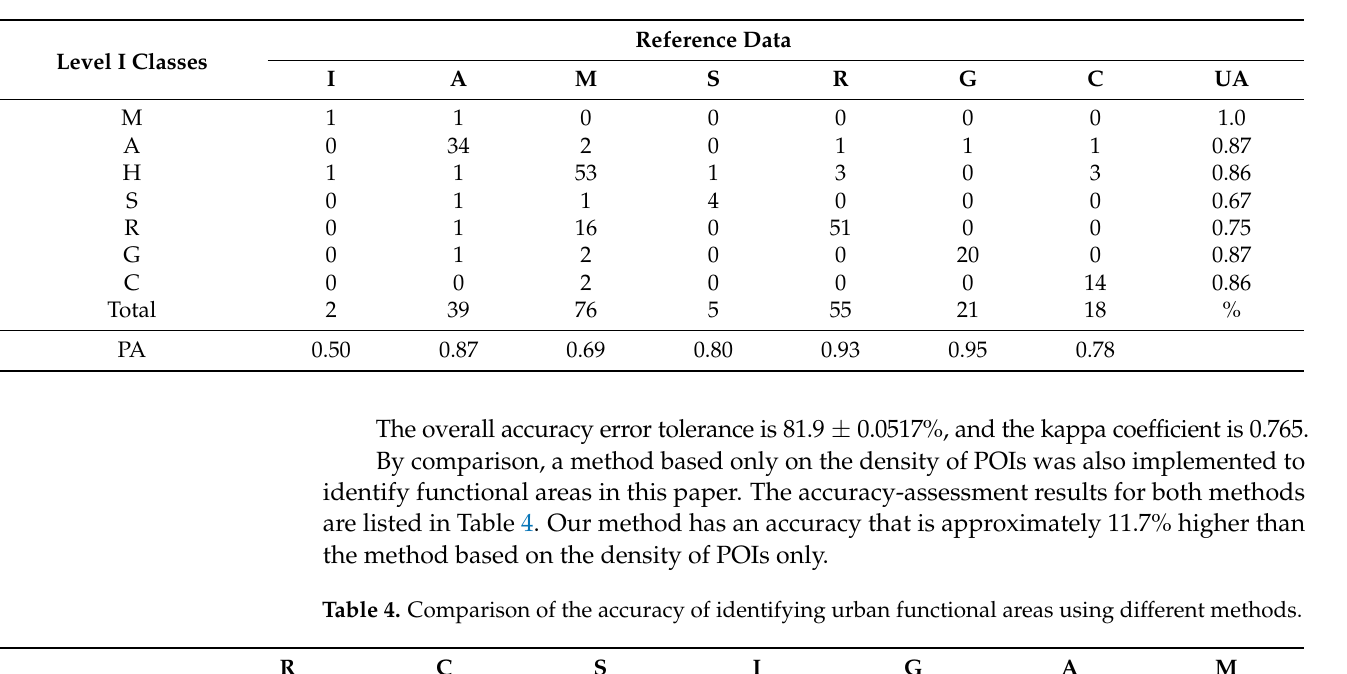
Table 3. Confusion matrix of the classification of Level I urban-land-use types.